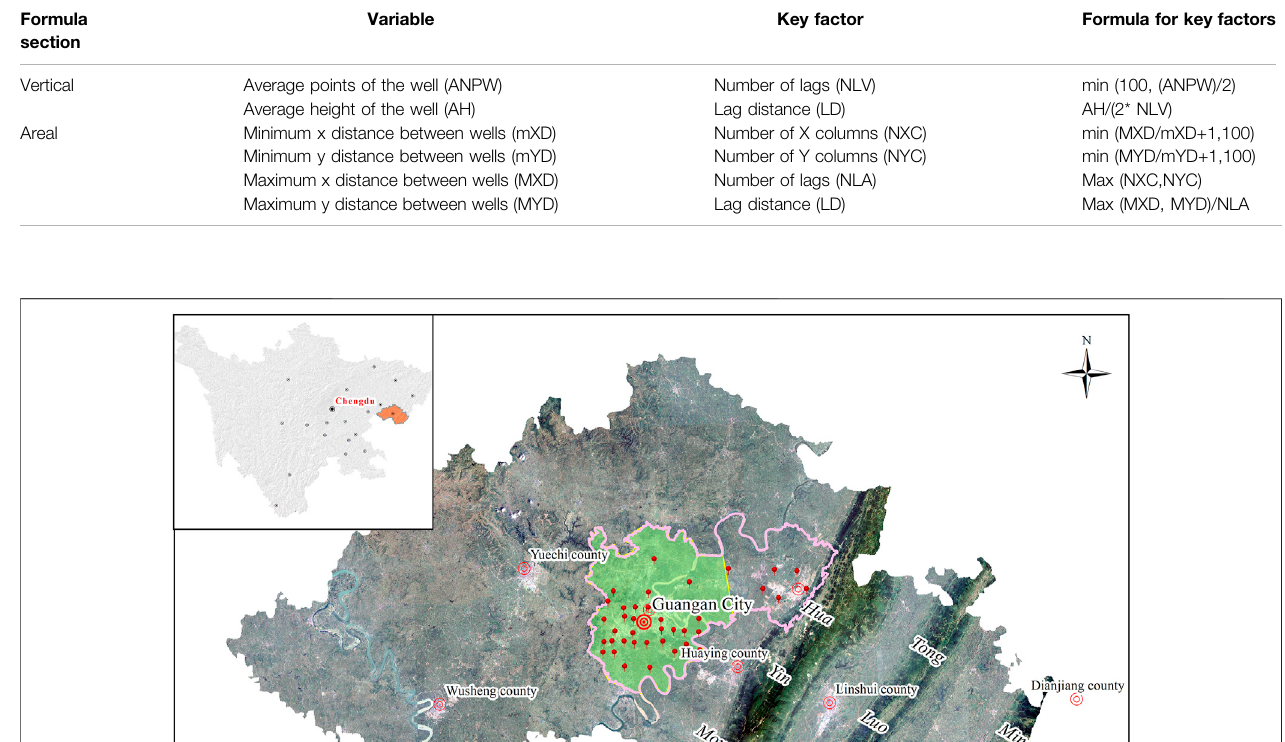
Table 1 . Tolerance and bandwidth are automatically